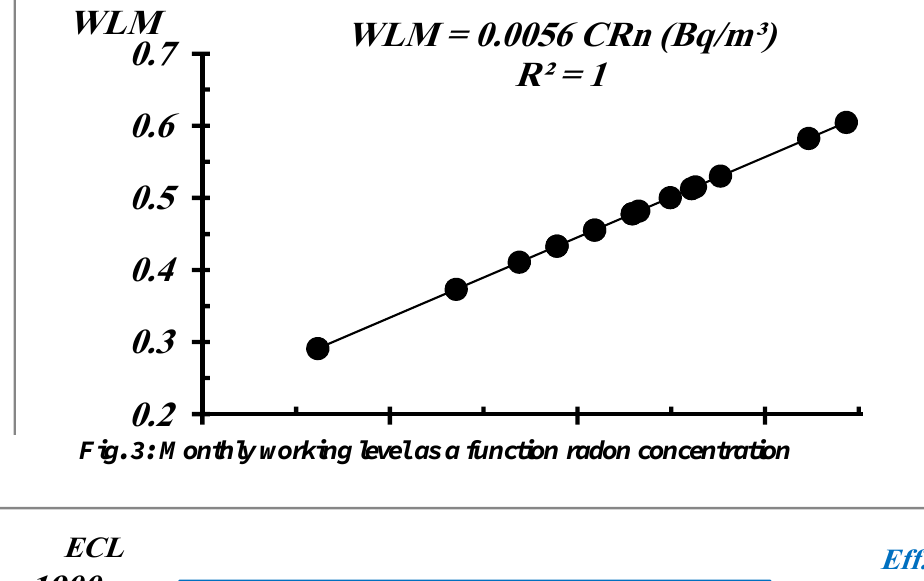
Fig. 3: Monthly working level as a function radon concentration